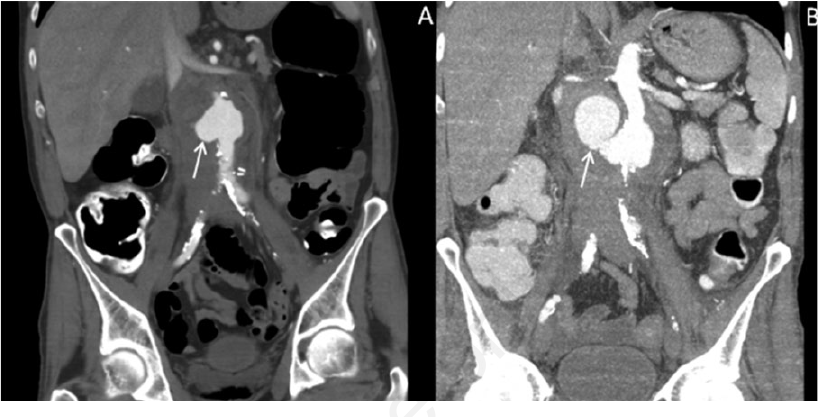
Figure 1. Contrast-enhanced coronal section of abdominal CT scan showing the infrarenal sacular mycotic aneurysm (see arrow) on presentation (A) and following con- tained rupture